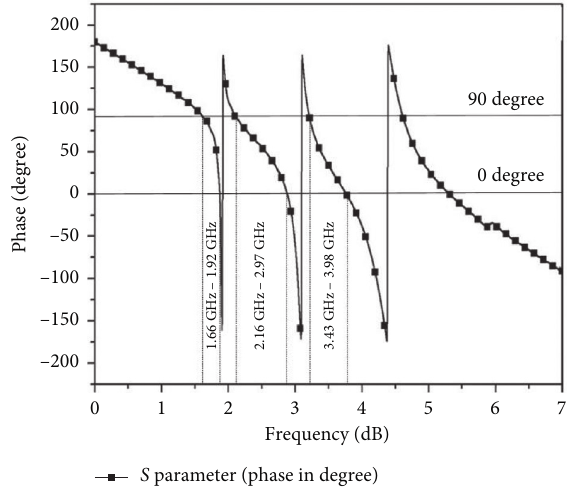
Figure 5: The simulation results phase diagram of ICPW-EBG unit cell.